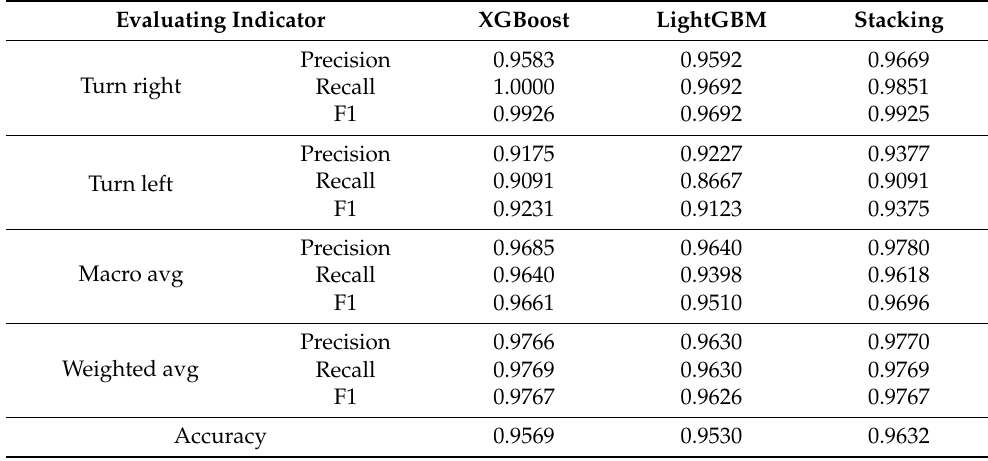
Table 8. Prediction results of lane-changing intention recognition with single-time feature.